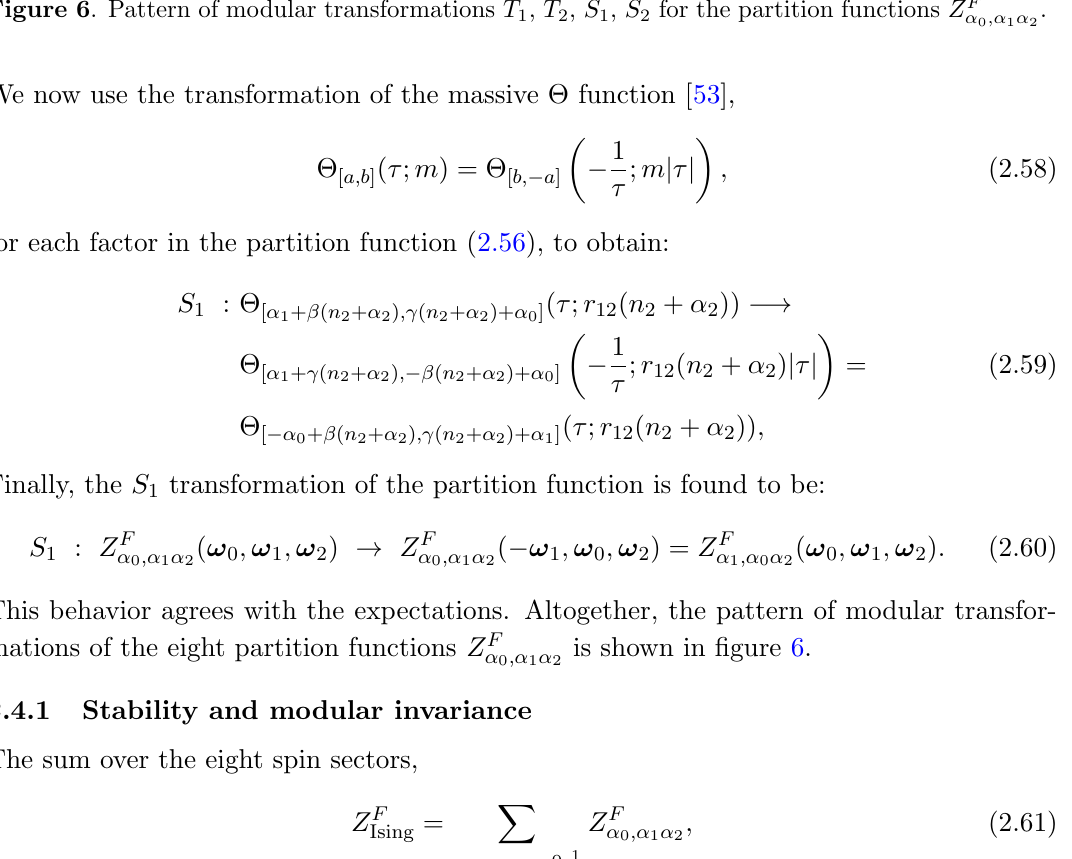
Figure 6 . Pattern of modular transformations T